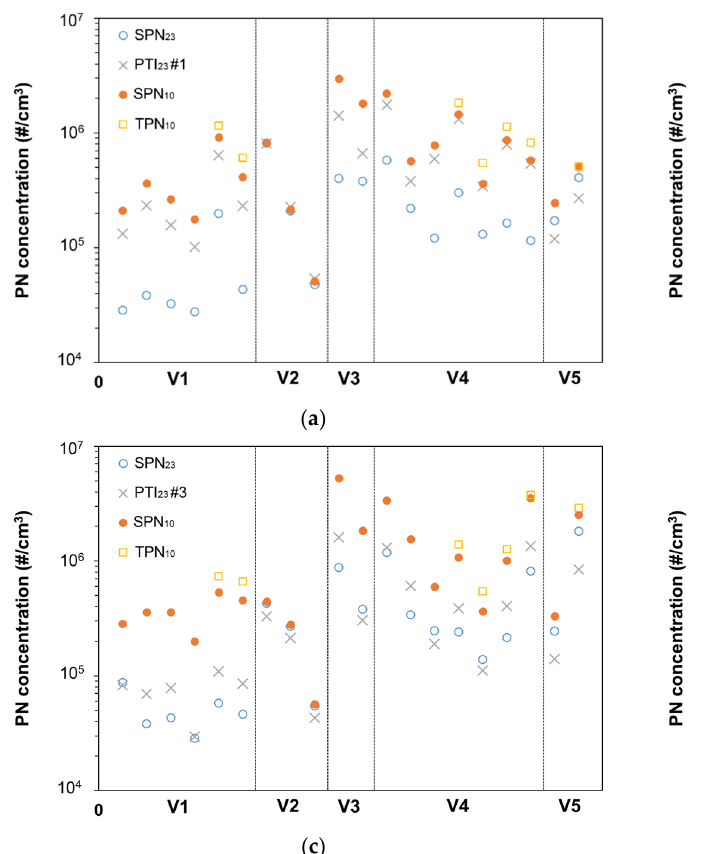
Table 4. Mean concentrations and sub − 23 nm and volatile fractions.